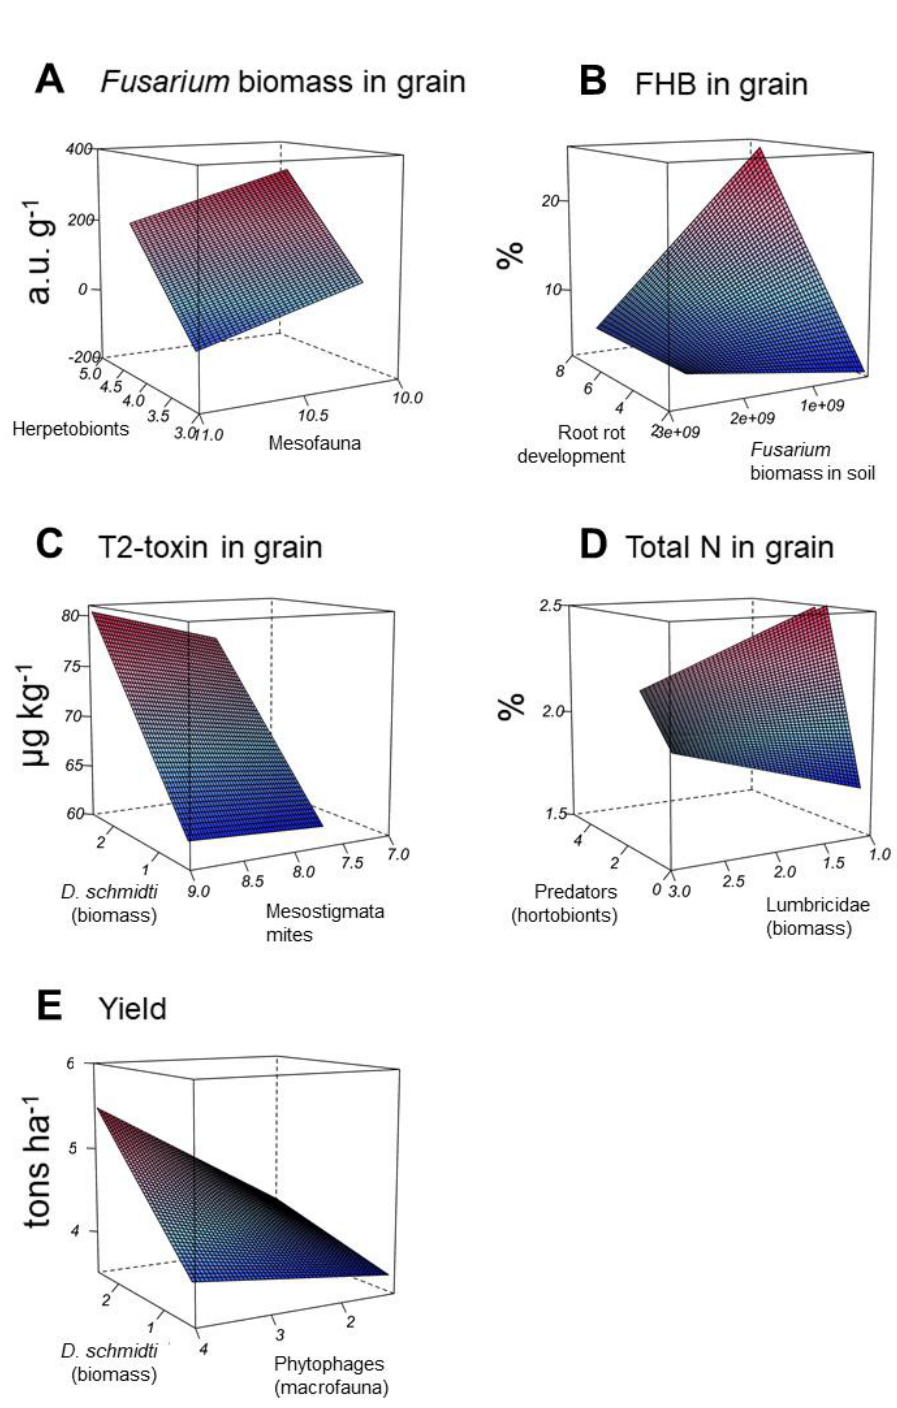
Figure 5. Regression surface plots of ( A ) Fusarium biomass in grain, ( B ) FHB in grain, ( C ) T2-toxin in grain, ( D ) Total N in grain, ( E ) Yield versus the regressors in the corresponding optimal models. The logarithmic values of abundance and biomass of invertebrates are given.